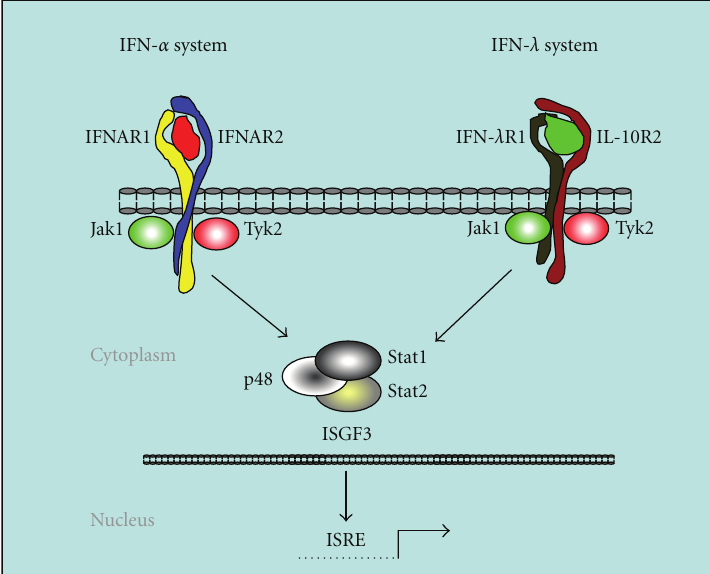
Figure 1: IFN- α and IFN- λ receptor systems and cell signaling. IFN- α and IFN- λ interact with distinct receptors, but the downstream signaling is similar. IFN- α interacts with receptors composed of IFNAR1 and IFNAR2, and IFN- λ interacts with a receptor composed of a specific chain, IFN- λ R1, and IL-10R2, a shared subunit with IL-10, IL-22, and IL-26. Both IFNs lead to the activation of the Jak kinases (Jak1 and Tyk2) and the formation of the transcription-complex-designated IFN-stimulated gene factor 3 (ISGF3), which includes p48, Stat1, and Stat2. ISGF3 complex binds to the IFN-stimulated response element (ISRE) and induces gene